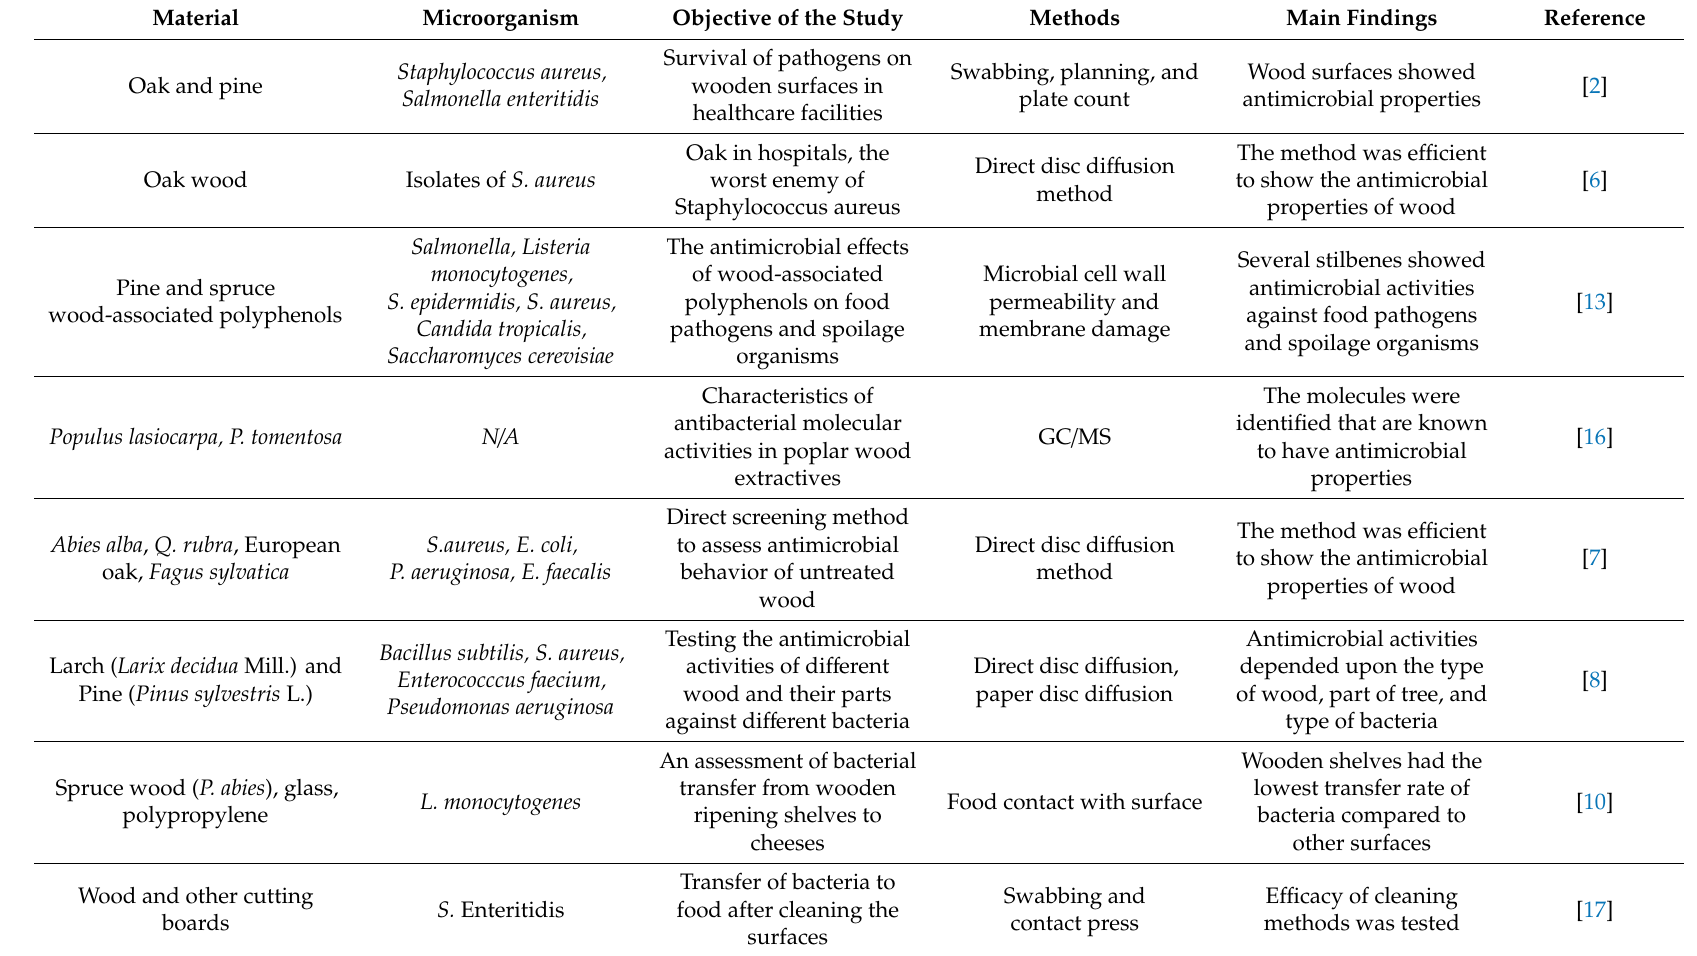
Table 1. Summary of publications selected for full-text